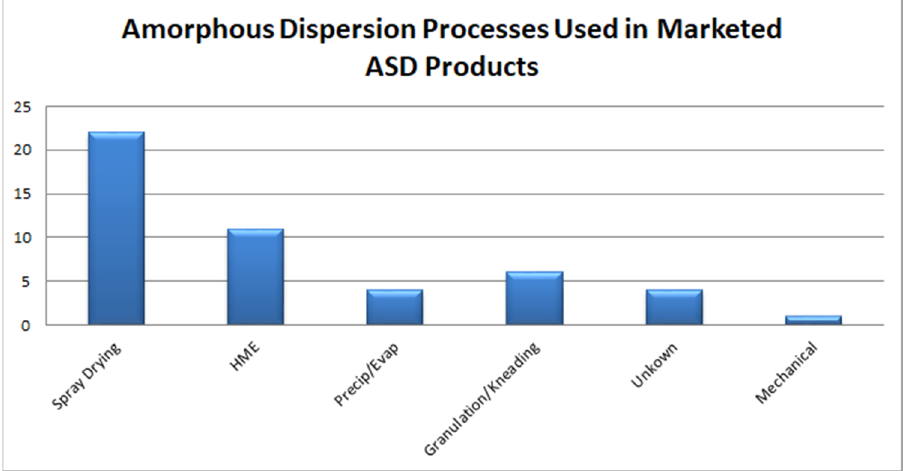
Figure 12. Number of marketed ASD products using different processes (source PharmaCircle™).